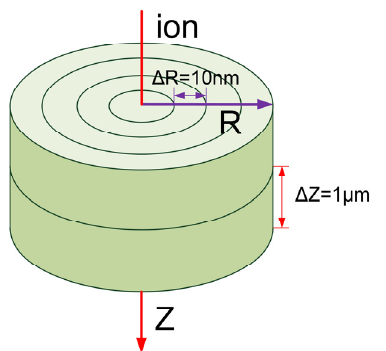
Figure 6. The schematic diagram of the cylindrical coordinate system used in the Geant4 simulation.